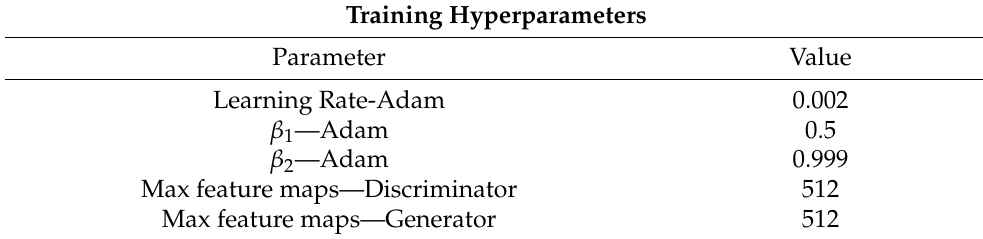
Table 3. GAN training hyperparameters were empirically determined to optimize network training